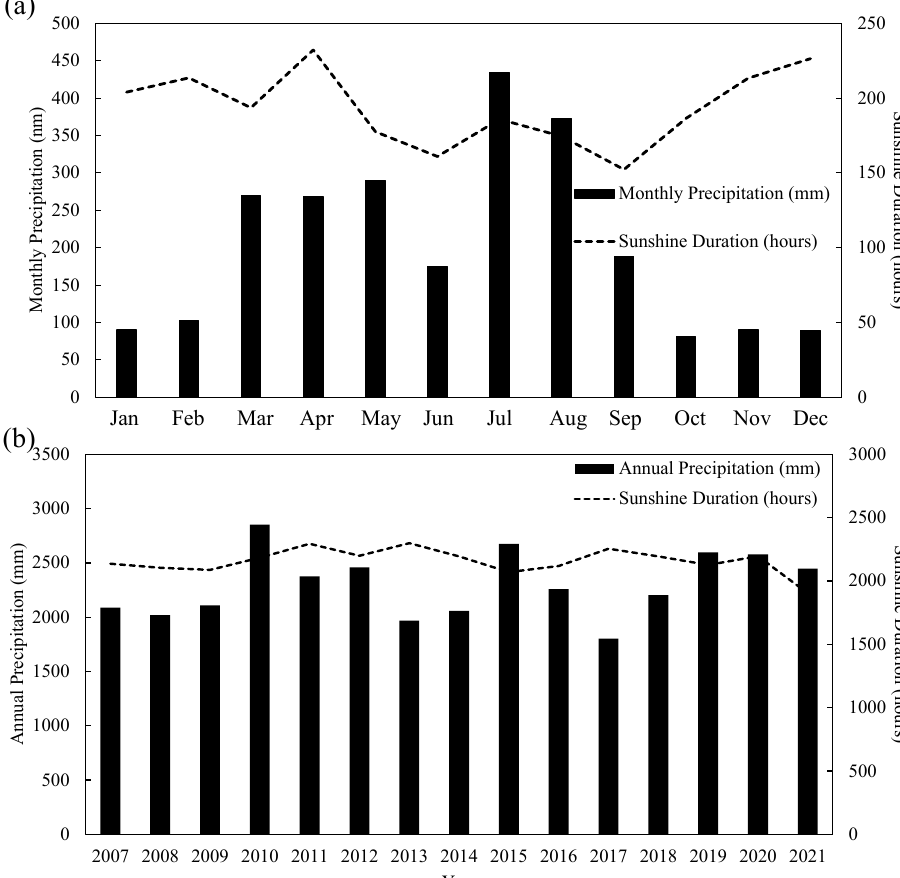
Figure 2. Precipitation and sunshine duration: ( a ) on a monthly basis and ( b ) on an annual basis. We used a spectrometer with a complementary metal ‐ oxide semiconductor (CMOS) sensor (C12880MA ‐ 10, Hamamatsu Photonics) and a shape ‐ memory alloy (SMA)–SMA fiber patch cable (M25L05, Thorlabs, Newton, NJ, USA) with a 0.22 numerical aperture to measure reflectance with a leaf clip (Figure 3, colorcompass ‐ LF). The grating equations provided by Hamamatsu Photonics were applied and then the spectral resolution was resampled in 5 nm bands across the entire wavelength domain from 400 to 850 nm. The plant probe has a halogen light source, and its leaf clip has replaceable white and black background standards. The reflectance of the target was calculated using the following equation: 𝜌 (cid:3090) (cid:3404) 𝑆 (cid:3090) (cid:3398) 𝐷 (cid:3090) 𝑊 (cid:3090) (cid:3398) 𝐷 (cid:3090) (1) where S , W , and D represent the target, a diffuse reflectance standard, and dark current, respectively, at wavelength λ (in nm). We applied five different preprocessing techniques to remove the baseline influence and to compensate for additive or multiplicative effects in the spectral data. All calculations were conducted using R statistical software, version 4.0.2 [31].